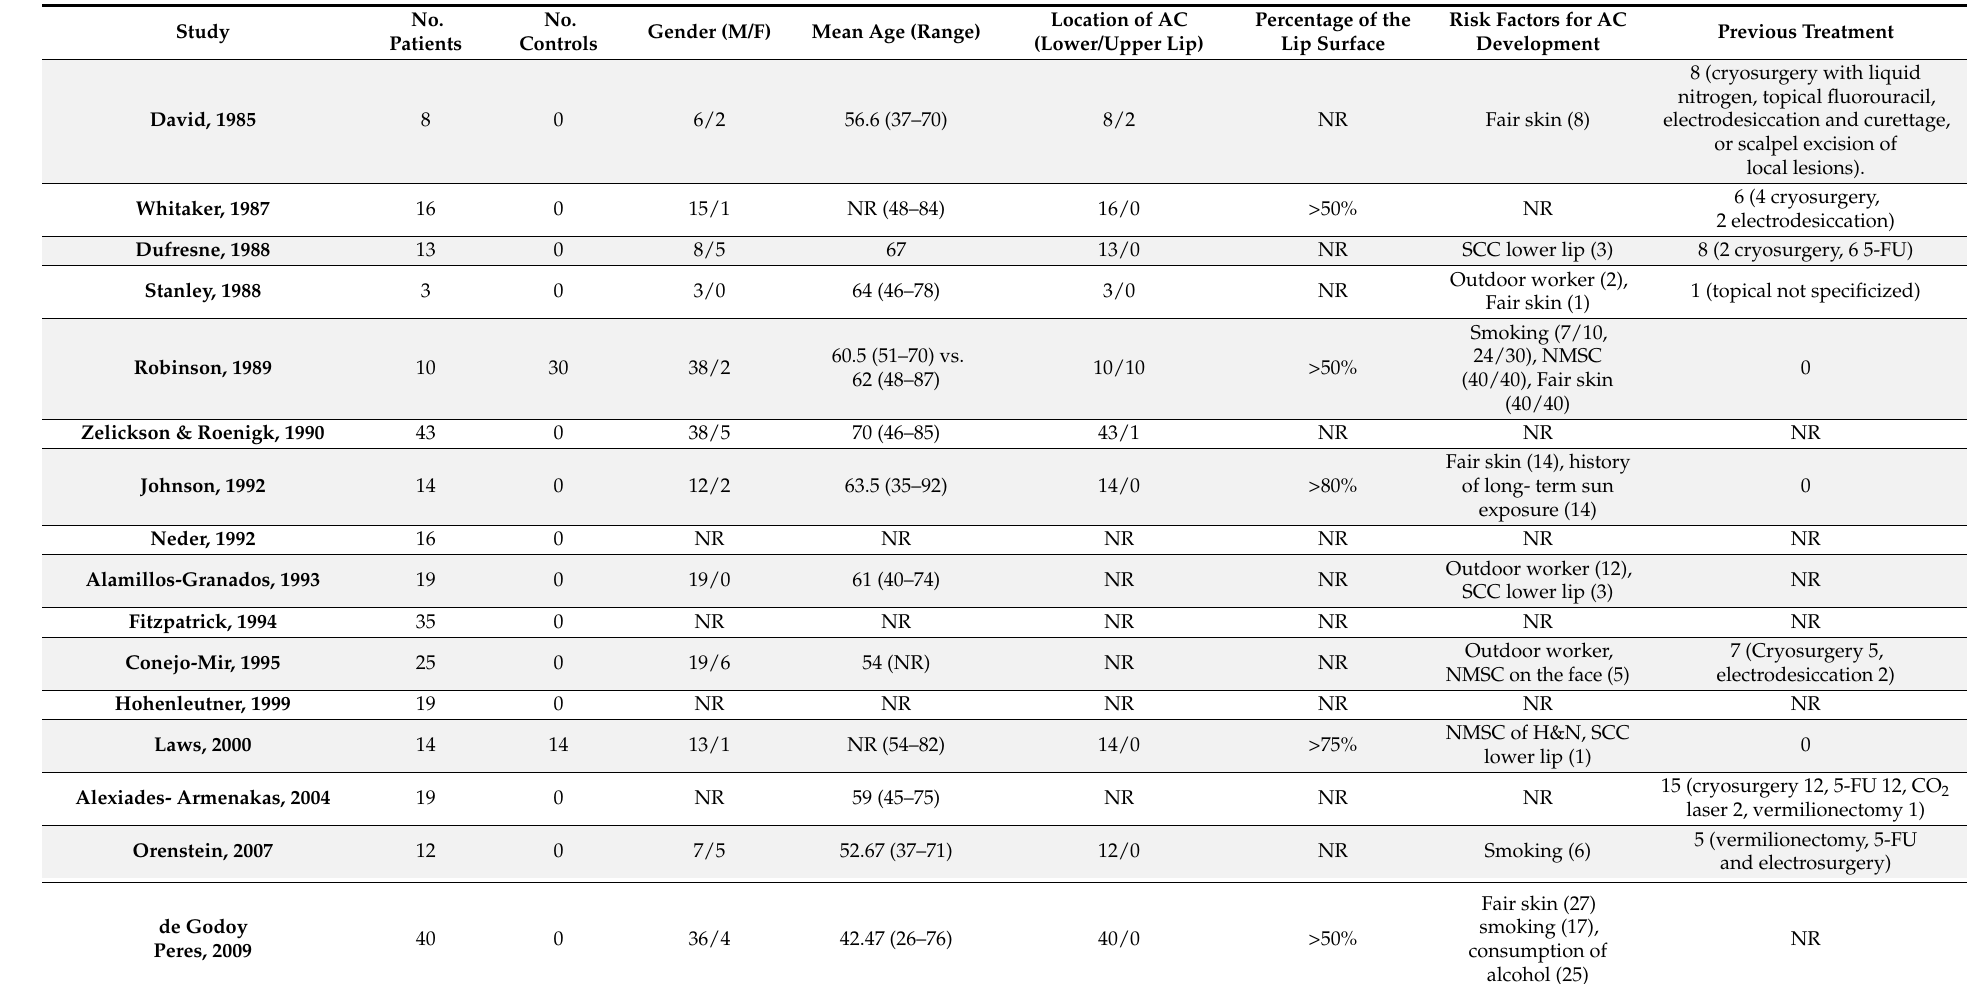
Table 2. Clinical and histopathological data of